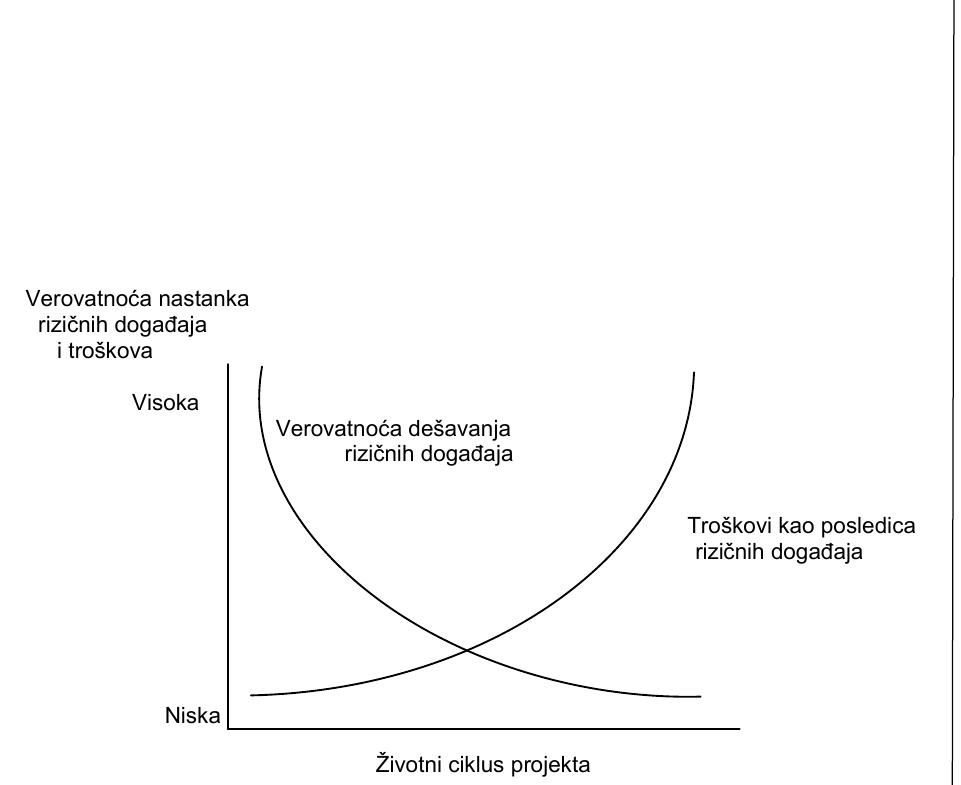
Figure 3 – Probability of risk events and development costs Slika 3 – Verovatno ć a dešavanja rizi č nih doga đ aja i